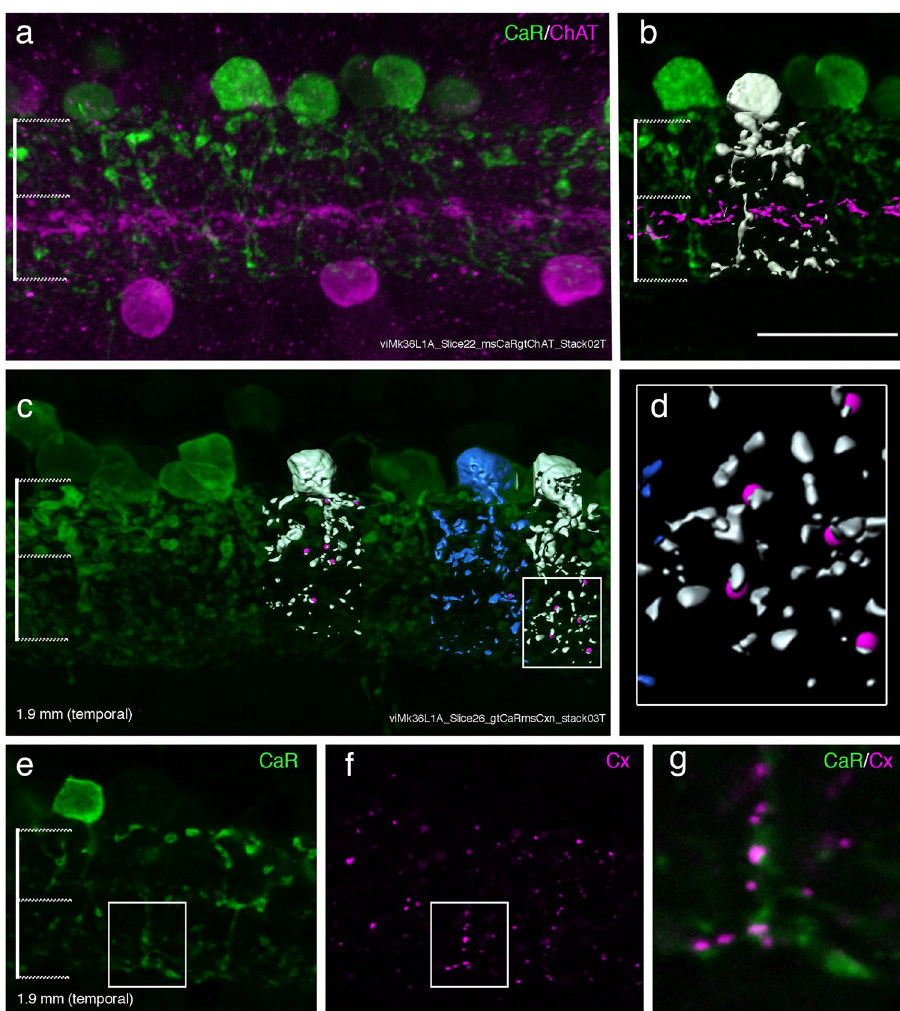
Figure 6. Gap junctions of AII cells. Confocal images of a vibratome section through central retina of macaque. ( a ) The section was processed with antibodies against calretinin (CaR) and antibodies against choline acetyltransferase (ChAT). ( b ) Shows a reconstructed AII cell from the section shown in a. The lines on the left indicate the OFF and ON sublamina. ( c ) Three-dimensional view of a section as processed with antibodies against calretinin (green) and connexin 36 (not shown). Three reconstructed AII cells are shown together with co-localized gap junctions (magenta). The box indicates the region shown in d. ( e,f ) Single confocal slice of a calretinin labelled AII cell (green) and the connexin immunoreactivity (magenta) in the same region. ( g ) Is the merged image of e and f. Scale bar shown in b = 20 µ m (valid for a, b, c, e,